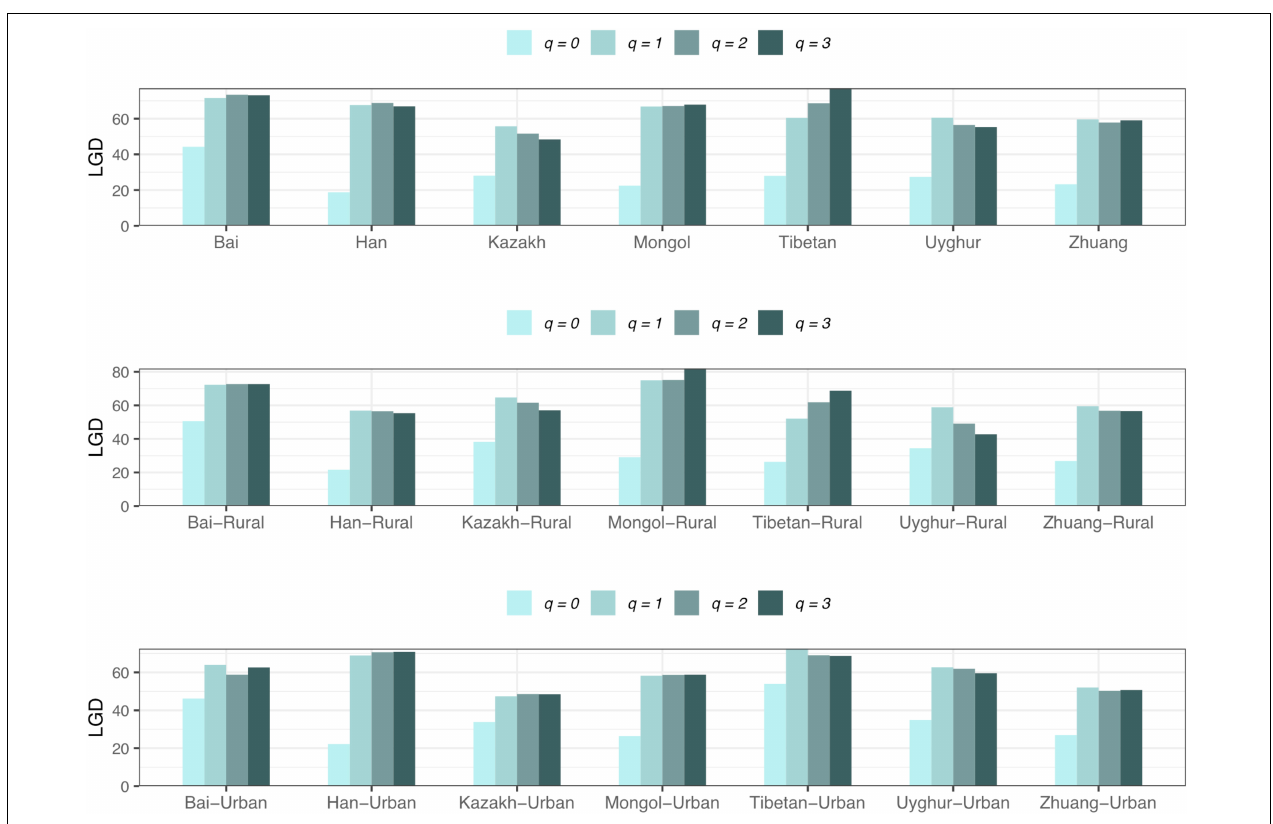
FIGURE 9 | The LGD profiles of all cohorts from Schemes 2A and 2B at the species